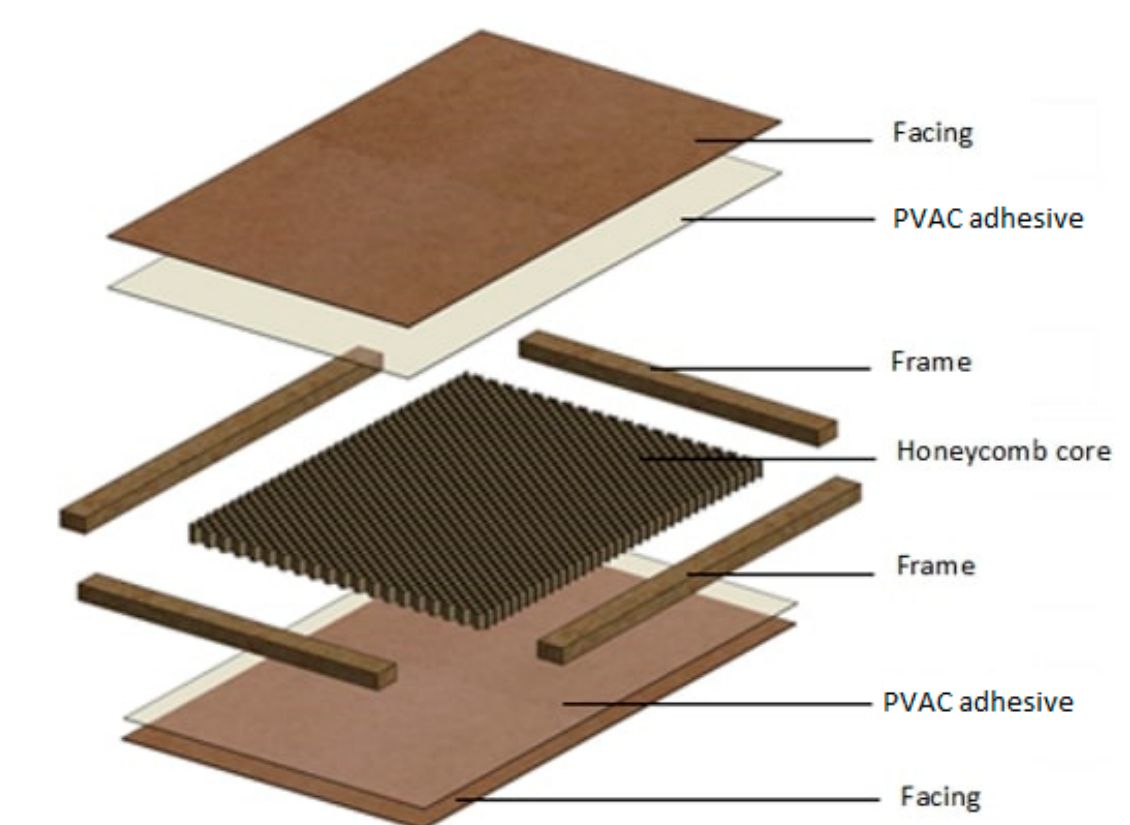
Figure 1. Construction of board on frame with honeycomb core.